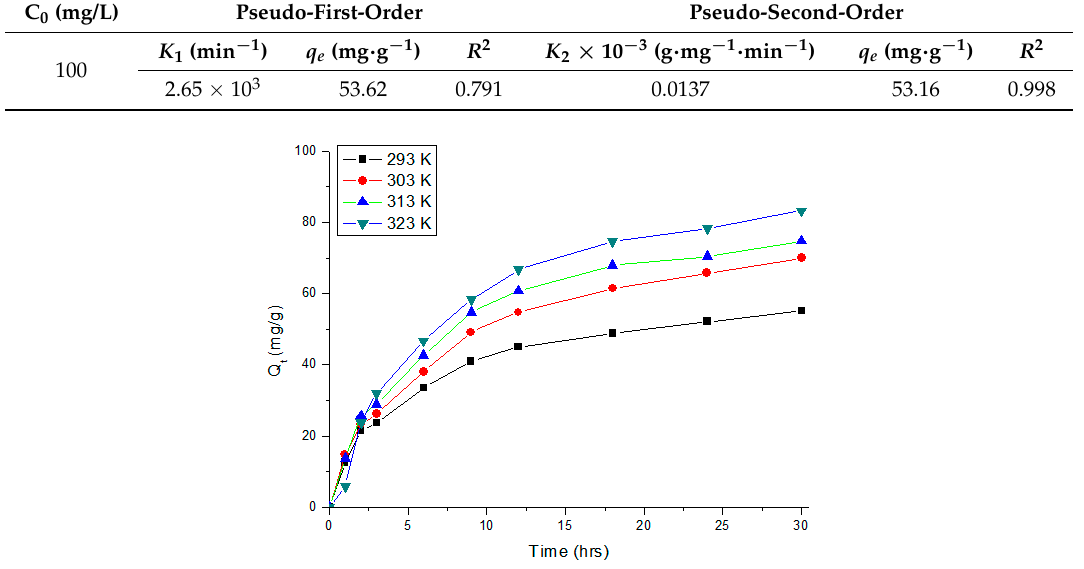
Figure 11. Kinetics curves of Cr(VI) adsorption by SS/KL blend beads at 293, 303, 313 and 323 K.